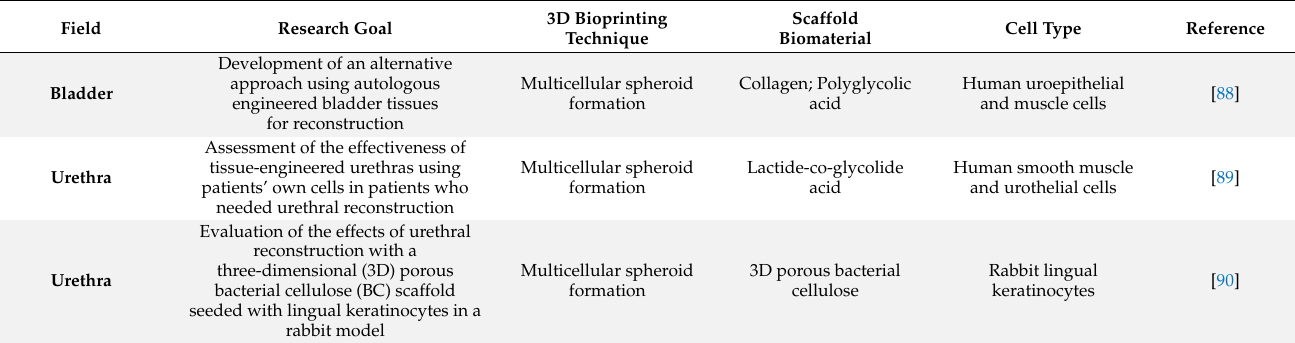
Table 3. Urological 3D Bioprinting Projects, Their Printing Techniques, and Bioink